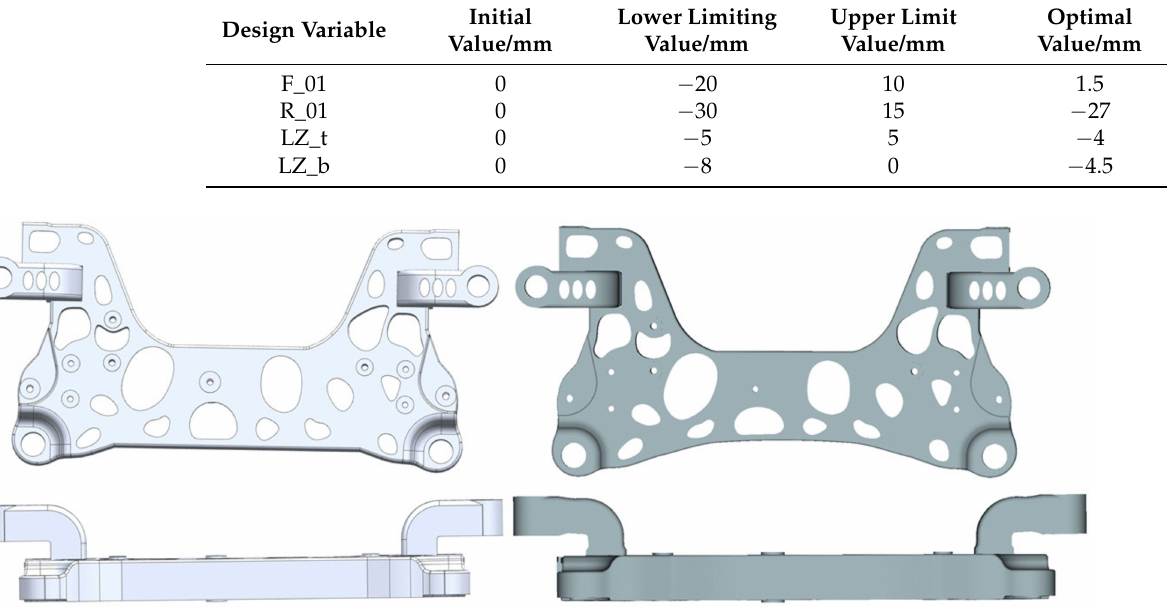
Figure 15. Digital and analogue comparison before and after multi-objective optimization of alu- minium alloy front subframe.